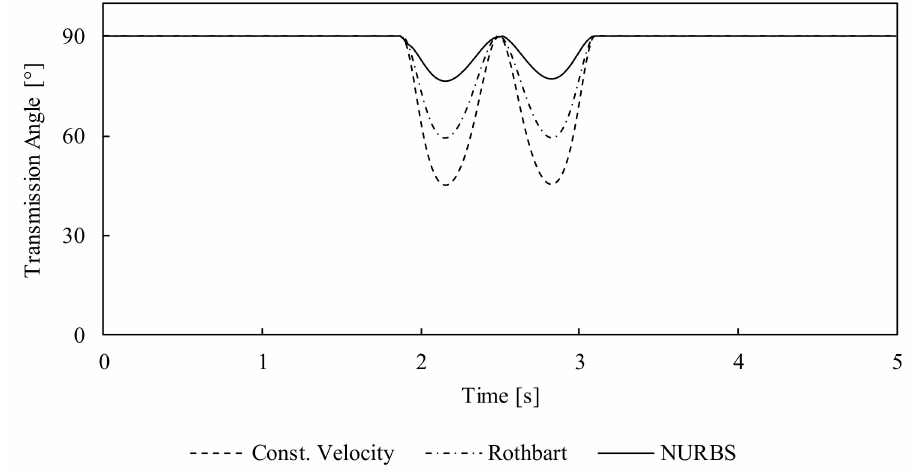
Figure 7. Transmission angle of the di ff erent